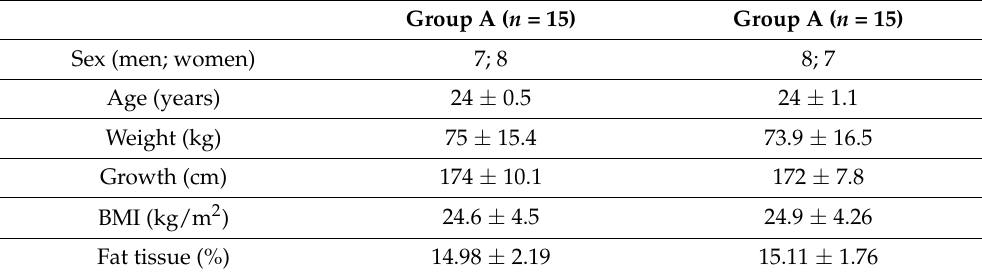
Table 1. Anthropometric data of